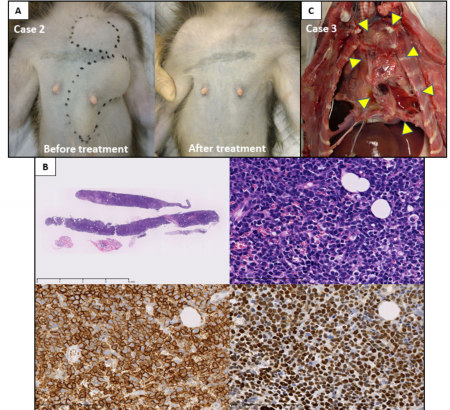
Figure 7. Development of PTLD with long-term graft survival after uterus transplantation in cynomolgus macaques. ( A ) Case 2 developed PTLD tumors in the anterior thorax and axilla on postoperative day (POD) 180 (left panel). The tumors disappeared completely one month following treatment due to repetitive administering of rituximab and cessation of MMF and TAC (right panel). ( B ) Biopsy specimen diagnosed as PTLD. Loupe image of needle biopsy specimens (H&E stain, bar = 4 mm); (upper left panel). Proliferation of atypical large lymphocytic cells are observed (H&E stain, bar = 100 µ m); (upper right panel). Large atypical cells are positive for CD20; bar = 100 µ m (lower left panel). Large atypical cells are positive for EBER in situ hybridization, bar = 100 µ m (lower right panel). ( C ) Autopsy of case 3 showing tumors (yellow triangles) in the pleural cavity and mediastinum, diagnosed as PTLD.